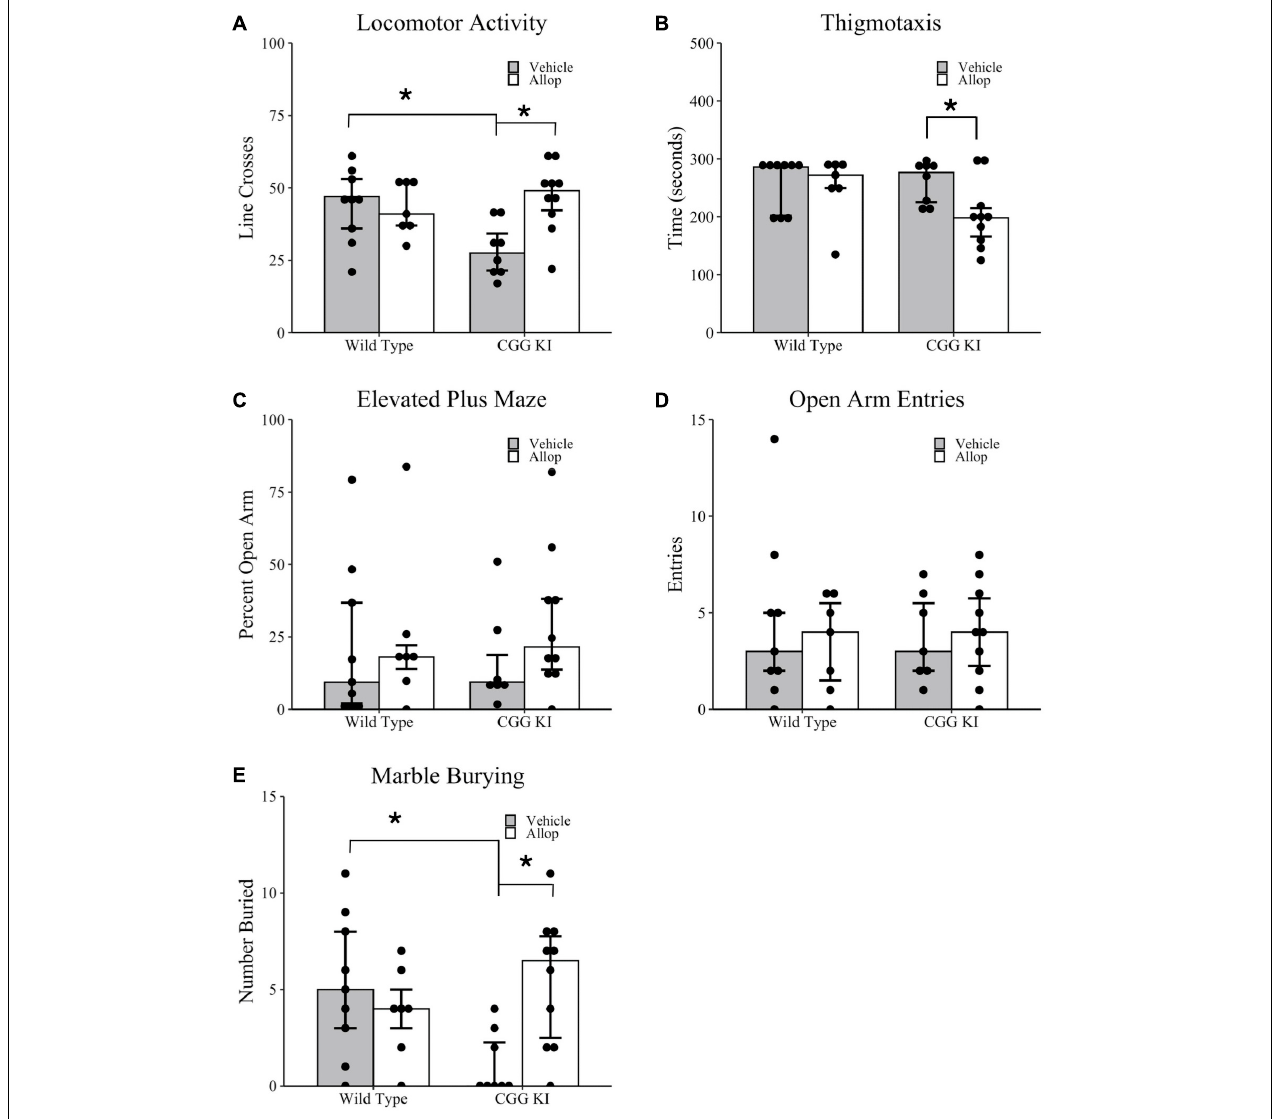
FIGURE 2 | Locomotor activity, arousal, and anxiety-associated behaviors in the CGG KI and wild type mice. Mice were treated for 10 weeks with Allop or vehicle control and evaluated for locomotor activity and thigmotaxis in the open field task (A,B) , anxiety-like measures in the elevated plus maze (C,D) , and repetitive digging behavior in the marble burying task (E) . Reported are (A) the number of lines crossed during a 5-min open field exploration; (B) the total time spent exploring the margins of the open field arena (i.e., thigmotaxis); (C) the percent time exploring the open arms in the elevated plus maze, as well as (D) the total number of entries into the open arms; (E) the percent of marbles buried in the marble burying task. * p < 0.05 as determined by Wilcoxon-Mann-Whitney (Locomotor Activity and Thigmotaxis) or Zero-Inflated Poisson Regression (Elevated Plus Maze and Marble Burying) followed by pairwise planned comparisons. Plots represent individual mice; bars represent median ± IQR. Wild type-vehicle ( n = 9), wild type-Allop ( n = 7), CGG KI-vehicle ( n = 8), CGG KI-Allop ( n =